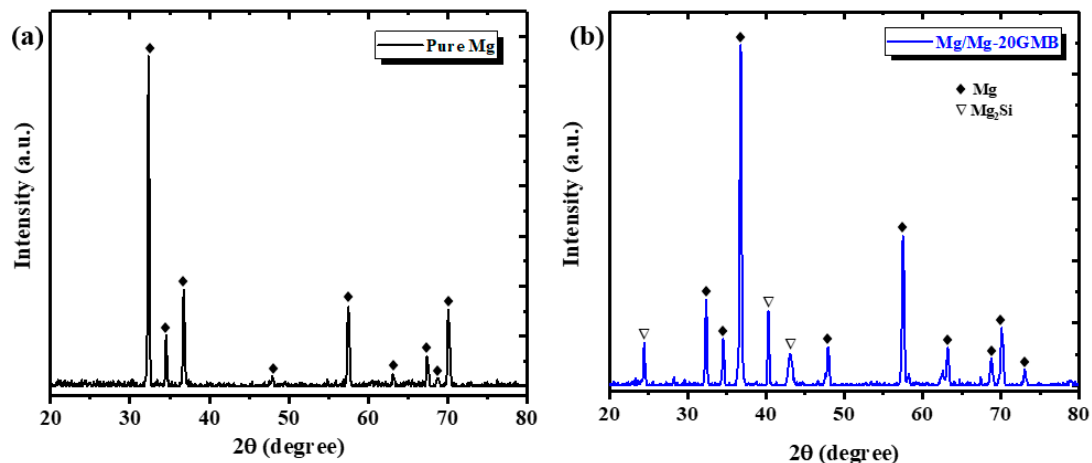
Figure 3. X-ray diffractograms of as-cast: ( a ) pure Mg and ( b ) Mg/Mg-20GMB hybrid composite. Figure 3. X-ray di ff ractograms of as-cast: ( a ) pure Mg and ( b ) Mg / Mg-20GMB hybrid composite.